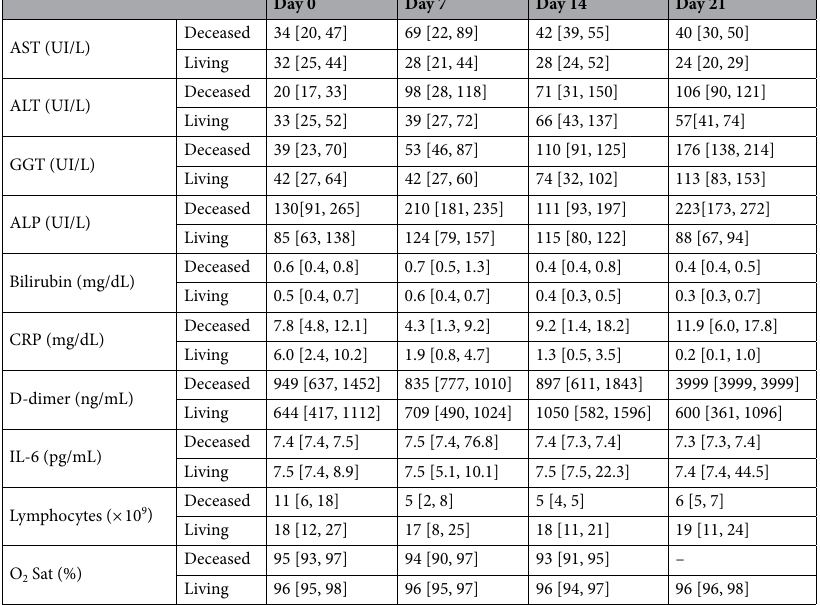
Table 2. Time course of transaminase levels according to final outcome. Data are expressed in medians and interquartile ranges (between